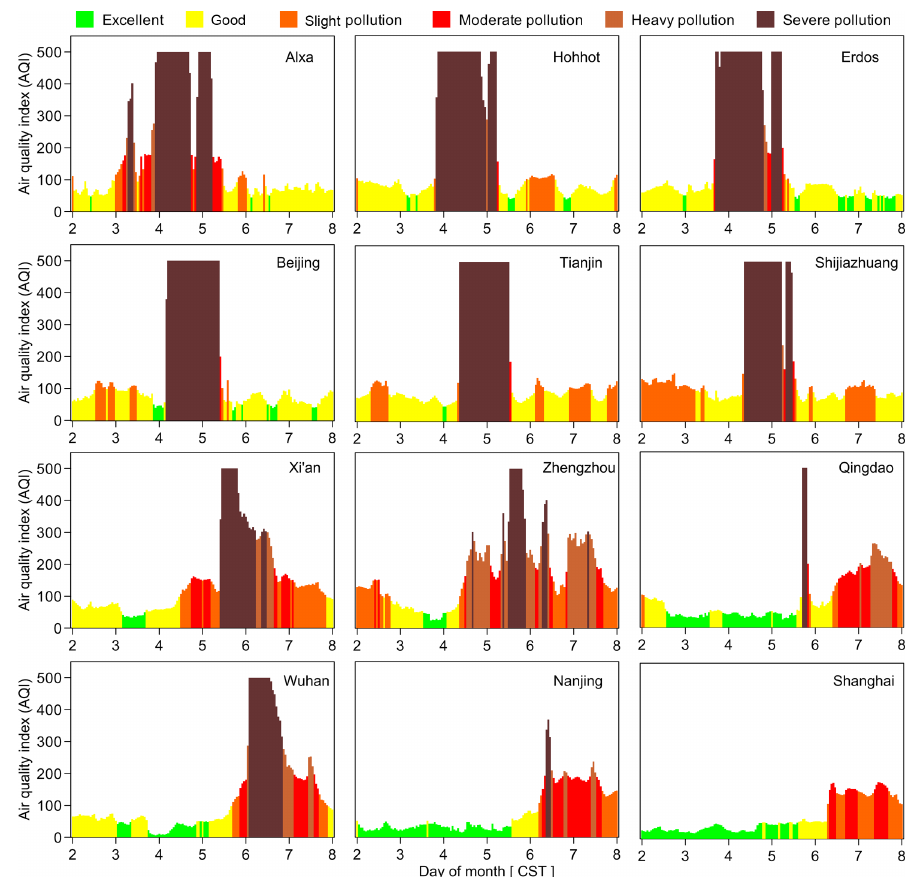
Figure 4. Hourly air quality index as observed for major stations in China during 2–7 May 2017. The PM 10 pollutant contributing to the hourly AQI is identified for each